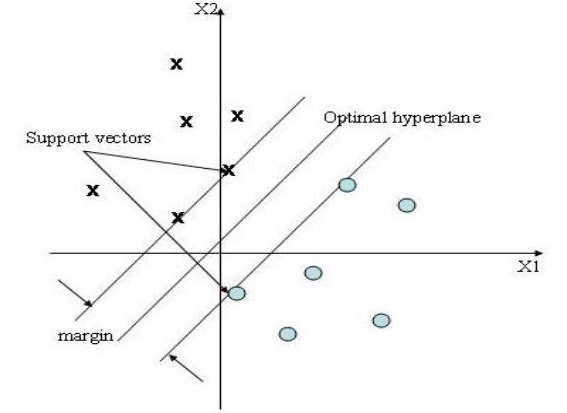
Figure 8: SVM classification with a hyper plane that maximizes the separating margin between the two classes (indicated by data points marked by "x"s and